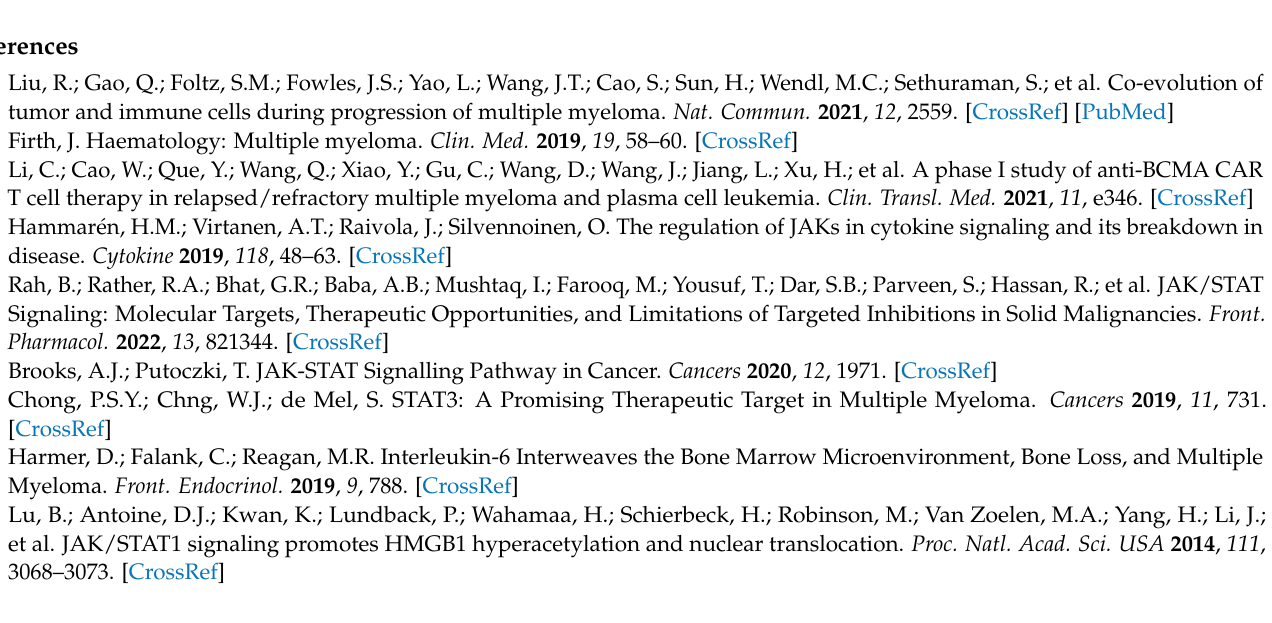
display the mean ± SD of three independent experiments with replicates. * p < 0.05, ** p < 0.001. Figure S2: IC50 values were calculated after treatment with 5, 10, 25, and 50 µ M GS for ( A – C ) U266, ( D – F ) RPMI 8226 and ( G , H ) MM.1S cells. Figure S3: ( A ) Graphical representation of live and dead analysis for Figure 1D. The graph displays mean ± SD where n = 3 and ** p <0.001. ( B ) The viability of RPMI 8226 cells was evaluated using a live/dead cytotoxicity kit at GS concentrations of 5, 10, 25, and 50 µ M. Green denotes live cells, while red denotes non-viable cells (Scale bar, 200 µ m). ( C ) Involvement of PTPs in GS-induced downregulation of STAT3. Total proteins were extracted from U266 cells, resolved using SDS-PAGE, and probed against SHP-1 and HSP60. Figure S4: GS sensitizes MM cells to BTZ. RPMI8226 cells were incubated with 10 µ M of GS and 5 nM of BTZ alone or in combination for 24 h. ( A ) The bar graph displays the cell viability determined by CCK-8 analysis. Data is presented as mean ± SD (n = 6. *** p < 0.0001). ( B ) The GS and BTZ- treated cells